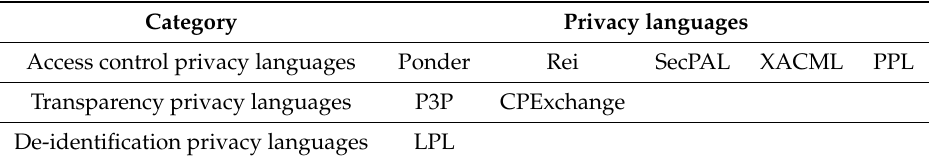
Table 2. Selection of privacy languages from the literature categorised into access control privacy languages, transparency privacy languages and de-identification privacy